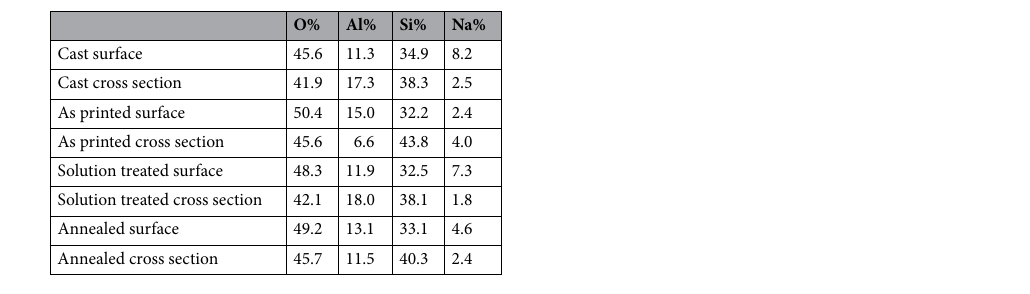
Table 2. Semi-quantitative EDS analysis performed on the surfaces and the cross sections of the different PEO treated samples (values in